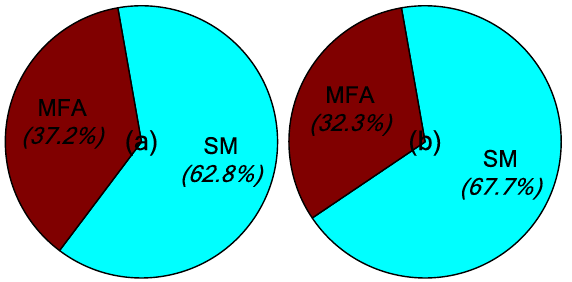
Figure 7. The contribution percentages of various methods to the feedback gains: ( a ) Actuators a / b , ( b ) actuator c .